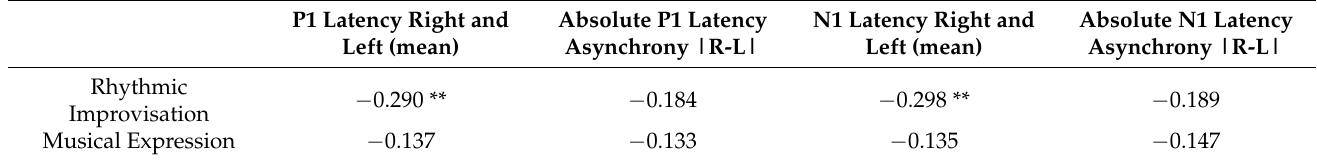
Table 6. Correlations of MEG variables under consideration with the musical performance variables rhythmic improvisation and musical